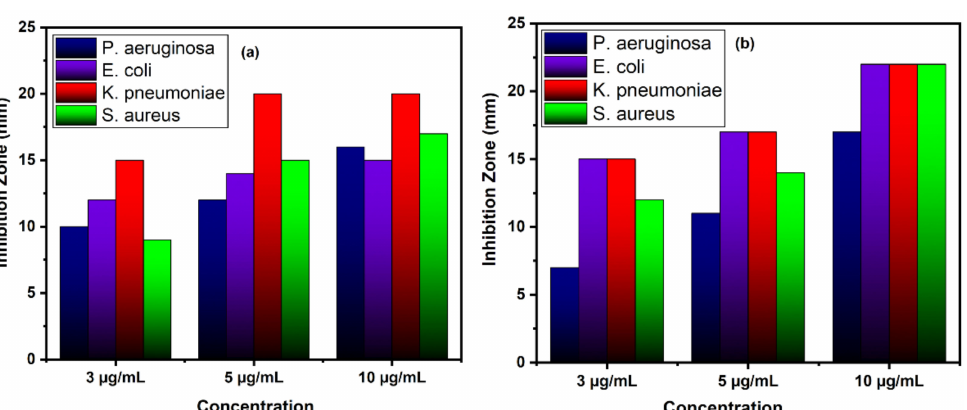
Figure 10. Bar graph showing the diameter of the zone of inhibition (in mm) produced by ( a ) pure and ( b ) Zn-doped CuO nanoparticles (NPs) against gram-positive and gram-negative